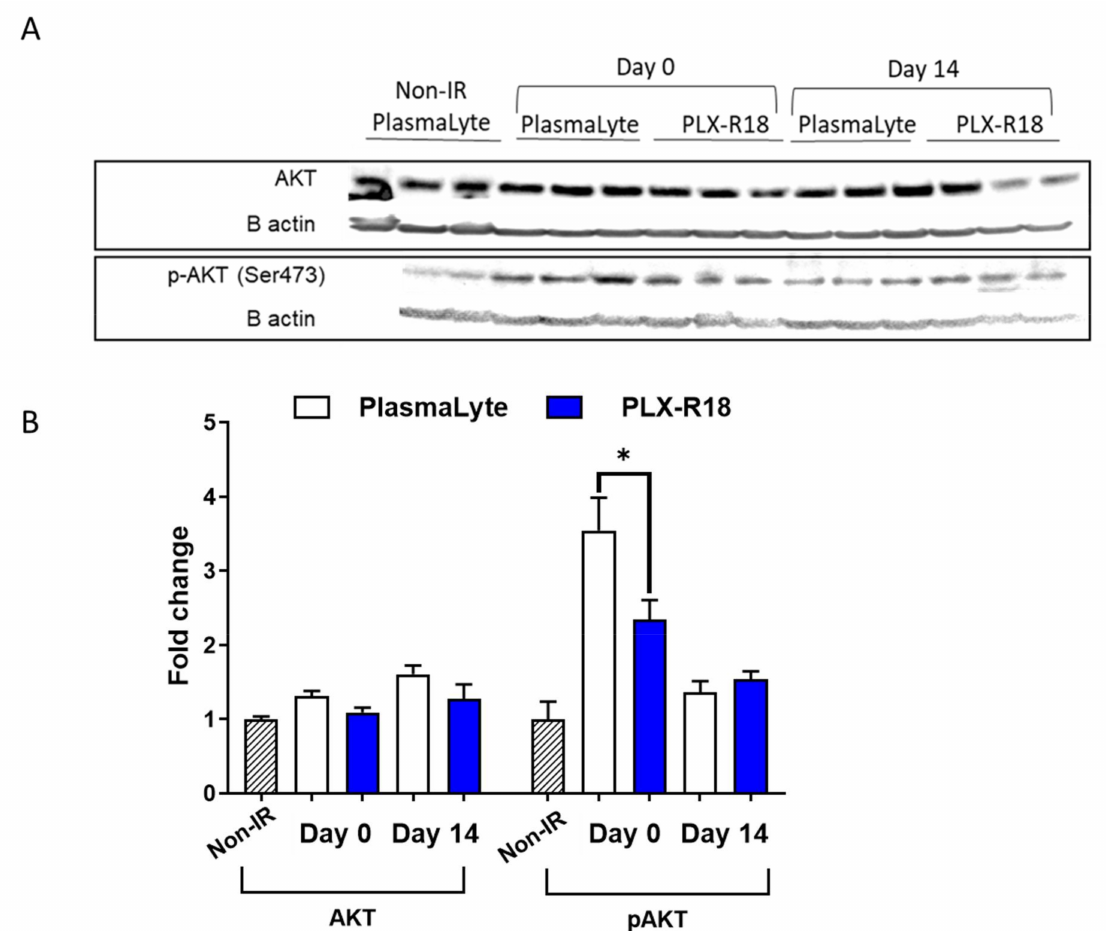
Figure 8. Differential levels of proteins and their phosphorylated forms as markers of inflammation due to radiation injury and effective amelioration by PLX-R18 treatment. Levels of AKT and pAKT were evaluated by Western blot analyses ( A ). The band density was quantified using image analyses software from BioRad ( B ) * indicates p <